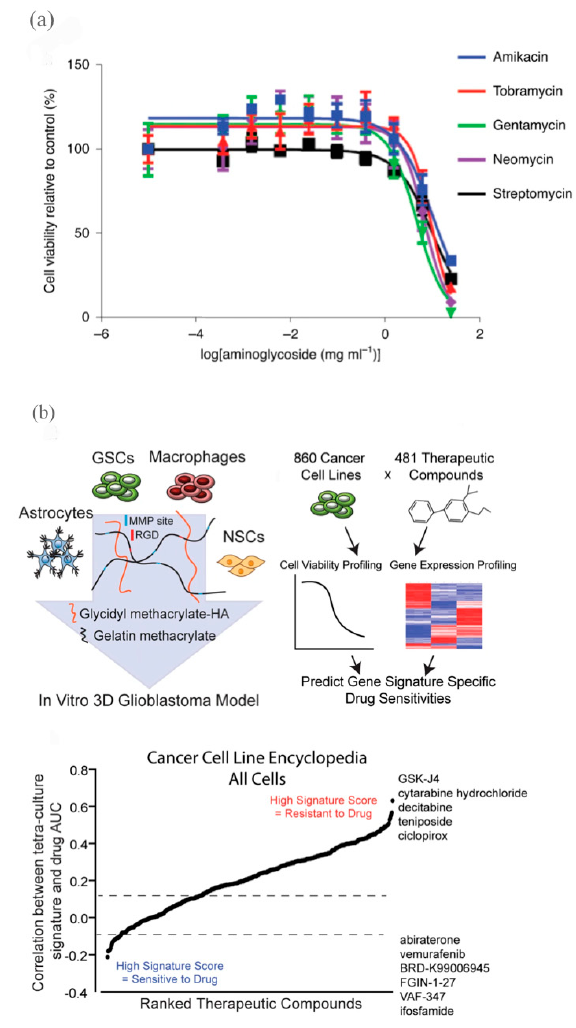
Figure 7. Bioprinted kidney and glioblastoma models for drug development. ( a ) Application of 96- well bioprinted organoids for testing viability in response to aminoglycoside antibiotics. The curves represent a non-linear fit for each compound, with n = 19 (amikacin), n = 24 (tobramycin), n = 30 (gentamycin), n = 30 (neomycin), n = 22 (streptomycin). Adapted from [68]. 2020, Nature Publishing Group. ( b ) Development of 3D glioblastoma model involving glioblastoma stem cells (GSCs), macrophages, astrocytes, and neural stem cells (NSCs) on left, methodology of evaluating drug sensitivity based on 3D tetra-culture gene expression signature from Cancer Cell Line Encyclopedia (CCLE) and the Cancer Therapeutic Response Platform (CTRP) datasets in middle, therapeutic efficacy prediction of drugs in CTRP dataset cancer cells using differentially expressed genes (as determined by RNA-sequencing) between 3D tetra-culture model and GSCs grown in sphere culture. Adapted from [92]. 2020, Nature Publishing Group.